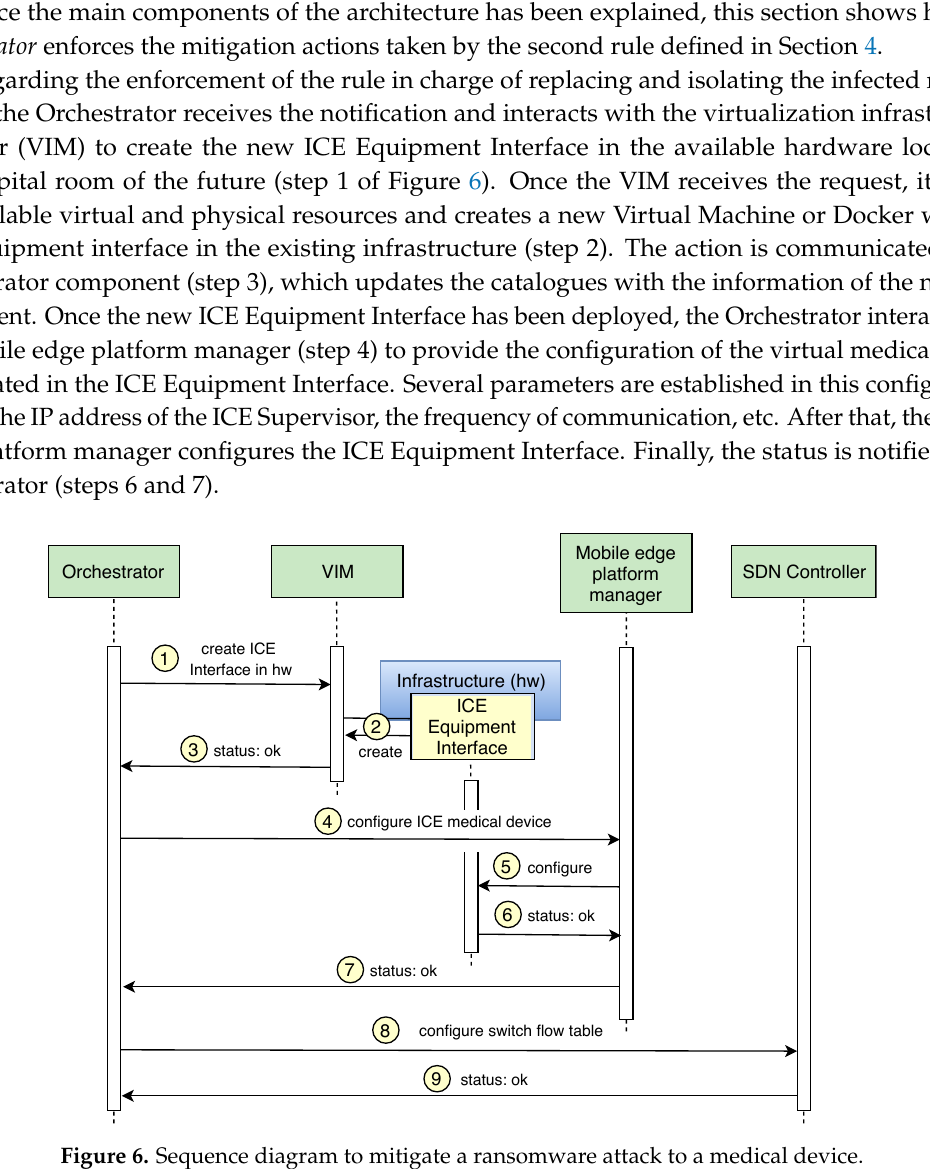
Figure 6. Sequence diagram to mitigate a ransomware attack to a medical